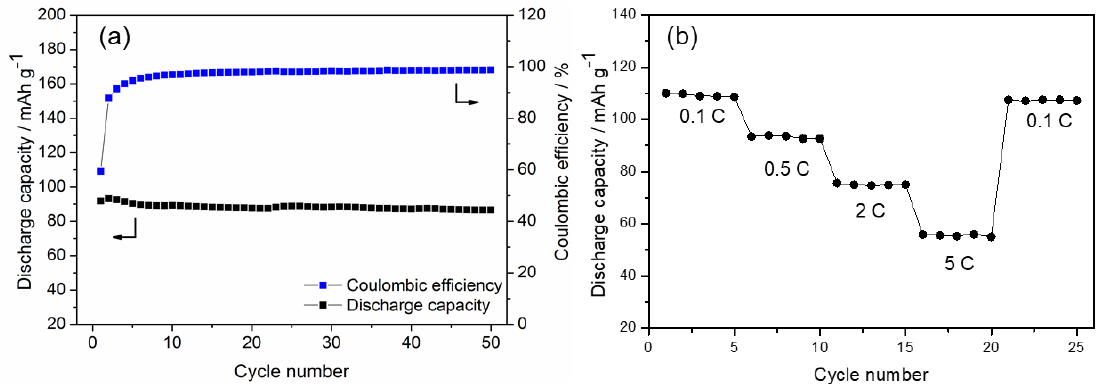
Figure 4. ( a ) Cycling performance and coulombic efficiency determined at 1 C and ( b ) rate capabilities of pristine NbO 2 .